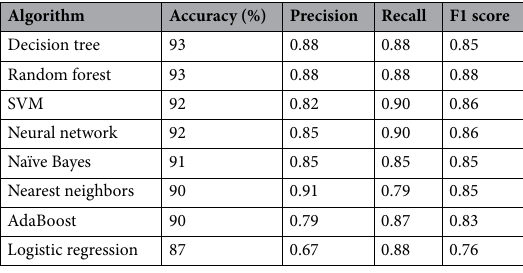
Table 3. Performance evaluation of each algorithm.